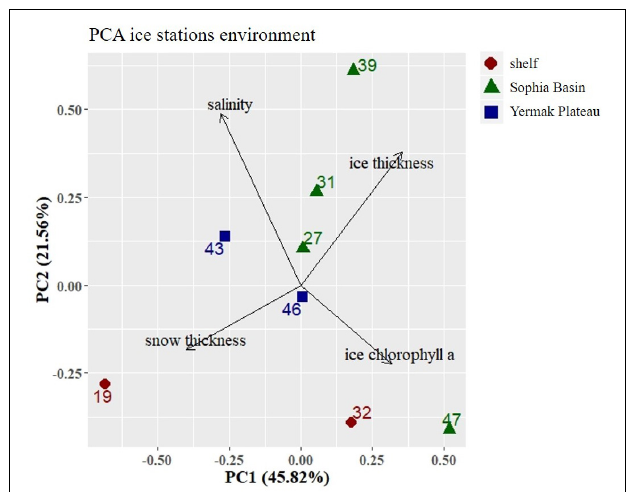
FIGURE 2 | Principal Component Analysis (PCA) plot of environmental parameters at the ice stations. Stations were color-coded according to geographical regions (shelf, Sophia Basin, and Yermak Plateau). Black arrows point into the direction of increasing values of environmental parameters in the ordination. Percentage values in axis annotations indicate the proportion of explained variance of the